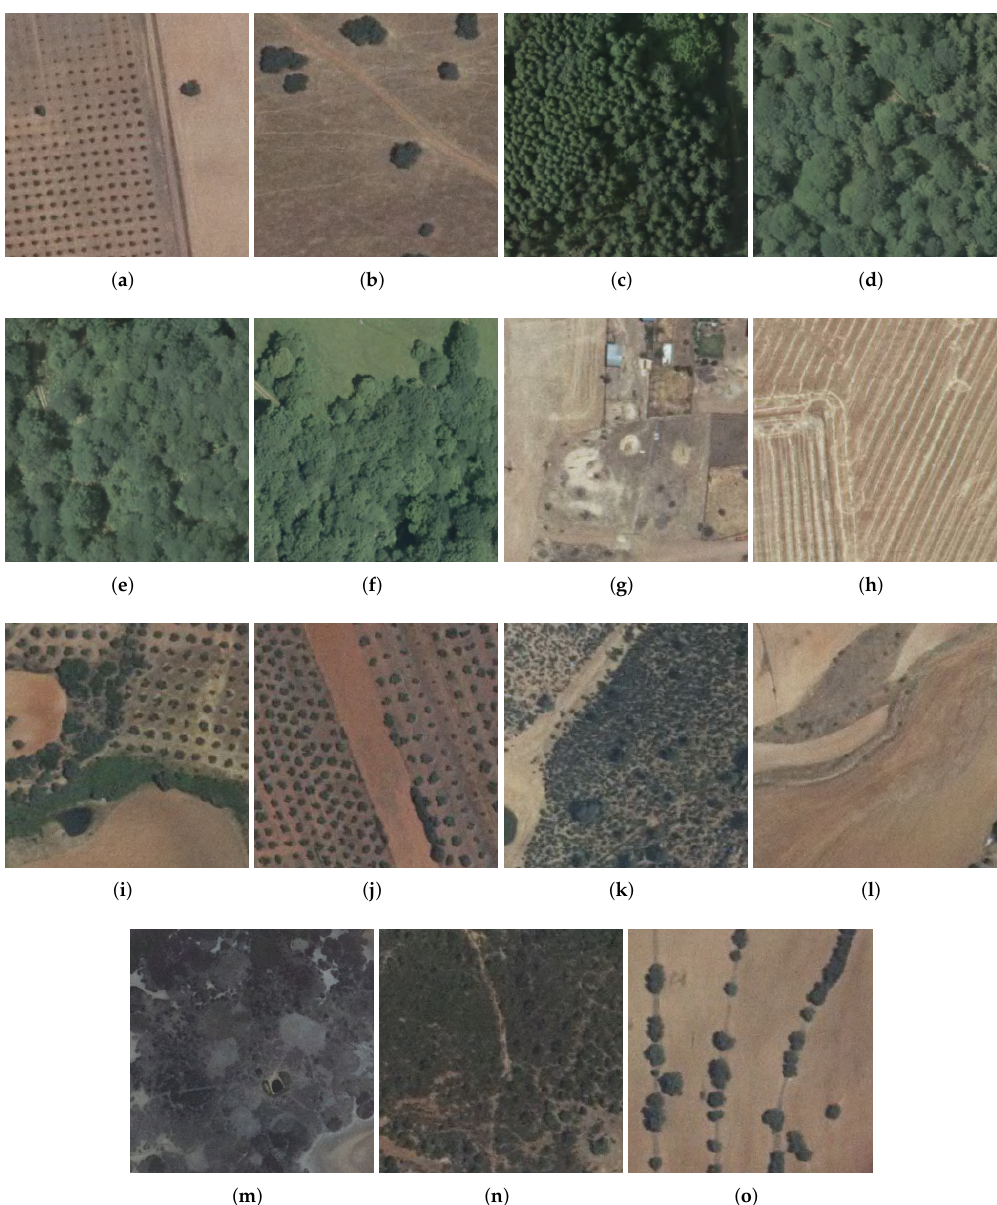
Figure 1. Examples of potential issues: ( a – f ) roads with complex contextual terrain or partial occlusions; and ( g – o ) images not containing roads that could be hard to